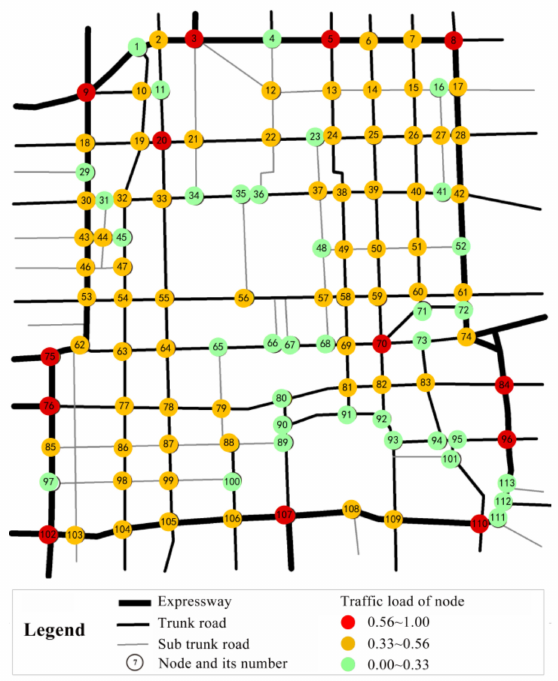
Figure 9. Spatial distribution of traffic loads of